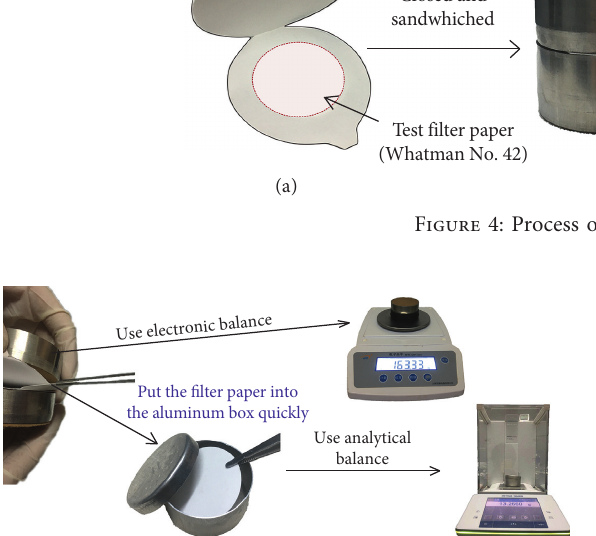
Figure 5: Process of removing specimens.